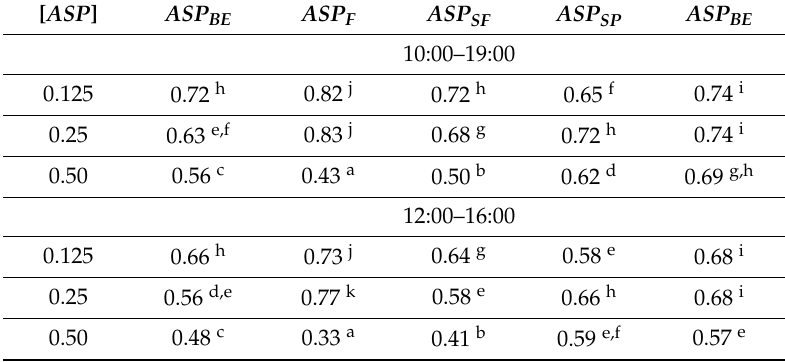
0.48 c 0.33 a 0.41 b 0.59 e,f 0.57